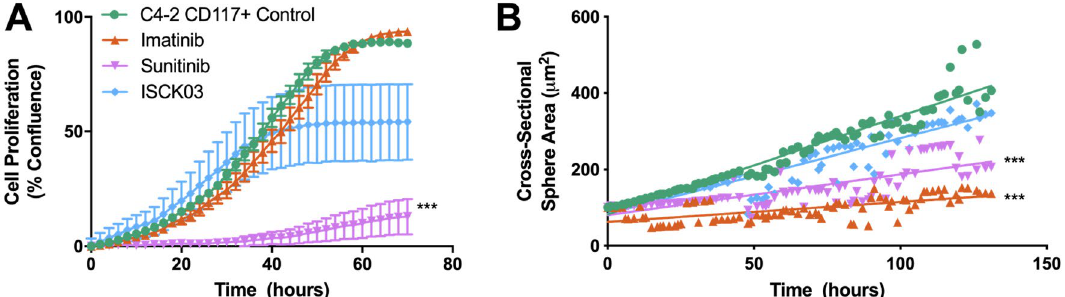
Figure 6. Inhibition of CD117 decreased proliferation and sphere formation. Sorted C4-2 CD117+ cells were treated with the broad tyrosine kinase inhibitors imatinib and sunitinib, as well as, ISCK03, a CD117- specific inhibitor. ( A ) Proliferation was measured by live-cell imaging and represented as mean percent confluence ± SEM ( n = 6). (.) Sphere formation was tracked using live-cell imaging and represented as mean sphere area ( n = 12). ***Represents p < 0.005 by one-way